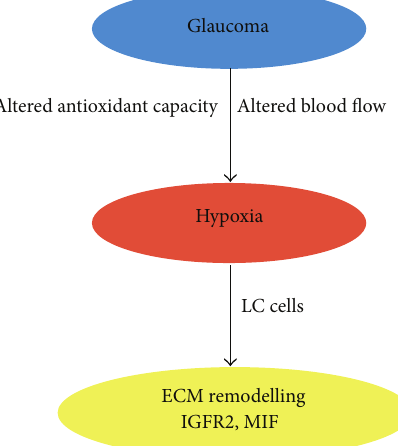
Figure 4: Hypoxia induces the expression of ECM remodelling genes in LC cells. It has been hypothesized that the increased IOP in glaucoma causes the blood flow to the eye to be altered, and this may be a cause of the hypoxic environment seen in glaucomatous eyes [79–83]. In addition to the altered blood flow, our group has shown that glaucomatous LC cells have decreased antioxidant capacity [73]. We have also shown that hypoxia can induce increased expression of ECMremodellinggenessuchasinsulin-likegrowthfactor2receptor (IGFR2) and macrophage migration inhibitory factor 1 (MIF) in LC cells